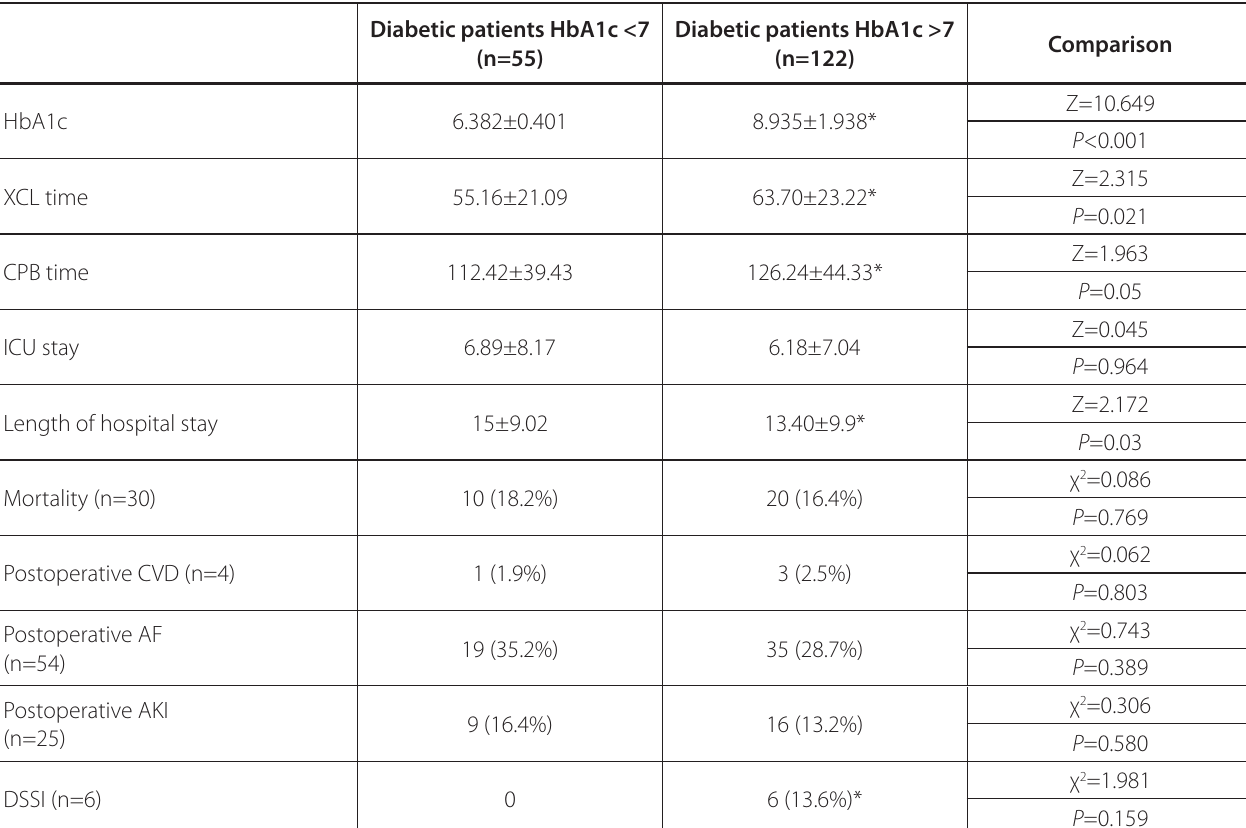
Table 4 . Evaluation of diabetic patients according to HbA1c